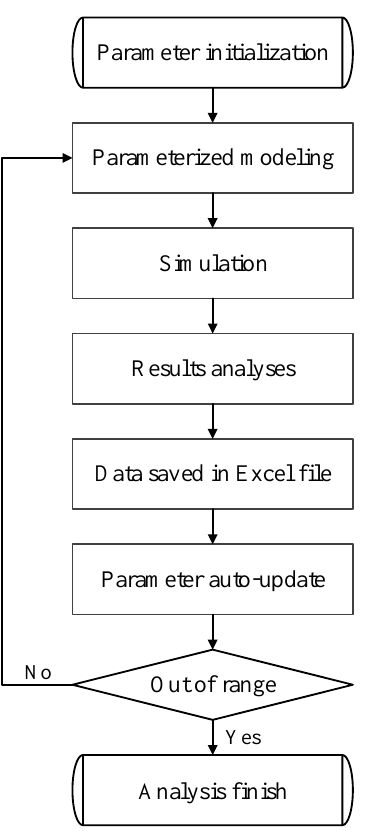
Figure 8. The continuous analysis process.